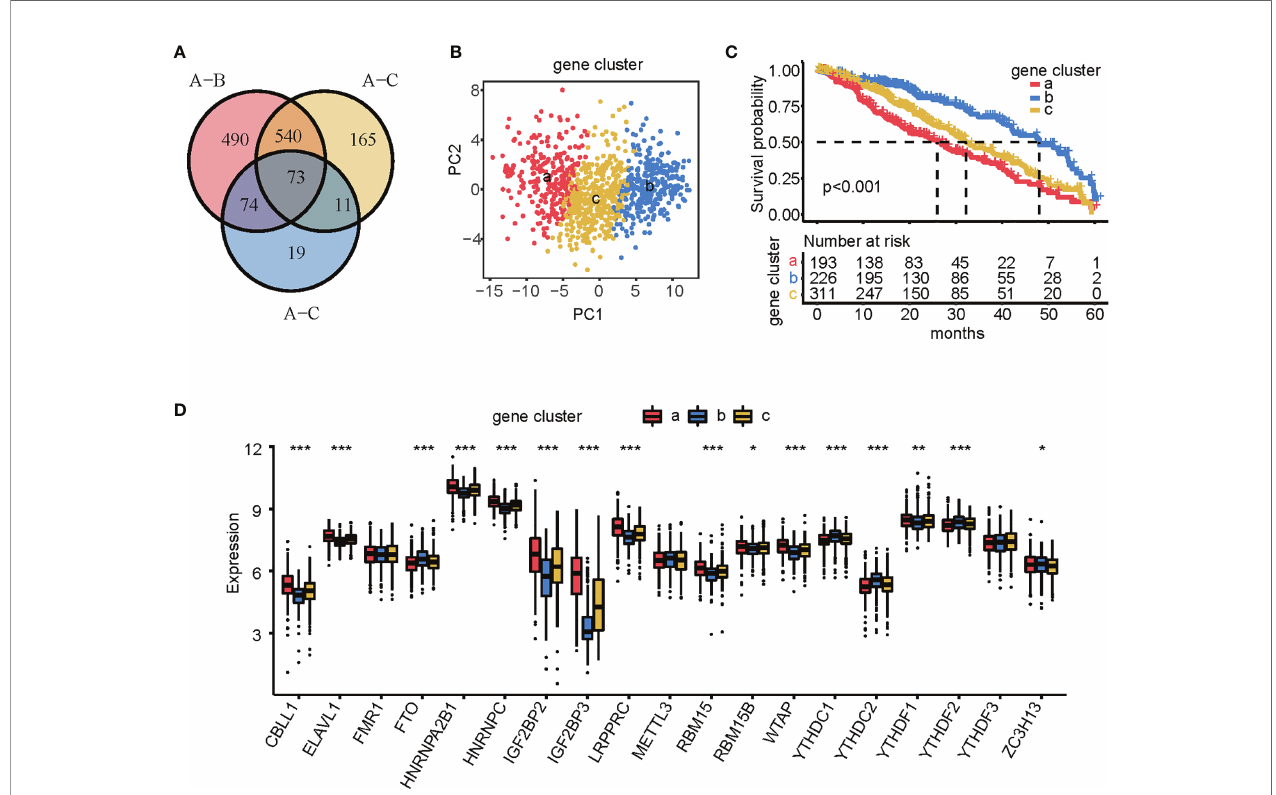
FIGURE 4 | Identi fi cation of m 6 A phenotype-related differentially expressed genes (DEGs) and construction of gene clusters. (A) Venn diagram showing 73 m 6 A phenotype-related DEGs between three m 6 A clusters. (B) Principal component analysis of three gene cluster patterns. (C) Kaplan-Meier curves showing the overall survival of the patients in the three gene clusters, including 193 cases of gene cluster a, 226 cases of gene cluster b, and 311 cases of gene cluster c. Log-rank test, p < 0.001. (D) Expression of the 24 m 6 A regulators in the three gene clusters. The upper and lower ends of the boxes represented interquartile range of values. The lines in the boxes represented median value, and black dots showed outliers. The asterisks represented the statistical p -value (* p < 0.05; ** p < 0.01; *** p <